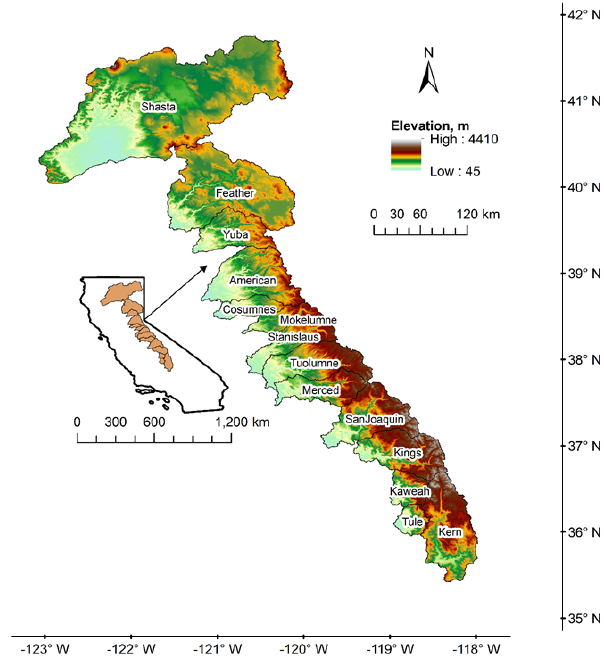
Figure 1. Map of California, indicating the extent of the river basins used in this study. The northern Sierra extends from Shasta to Cosumnes, the central Sierra from Mokelumne to Merced, and the southern Sierra from San Joaquin to Kern. Elevation was de- rived from US National Elevation Database digital elevation models (EROS Data Center,